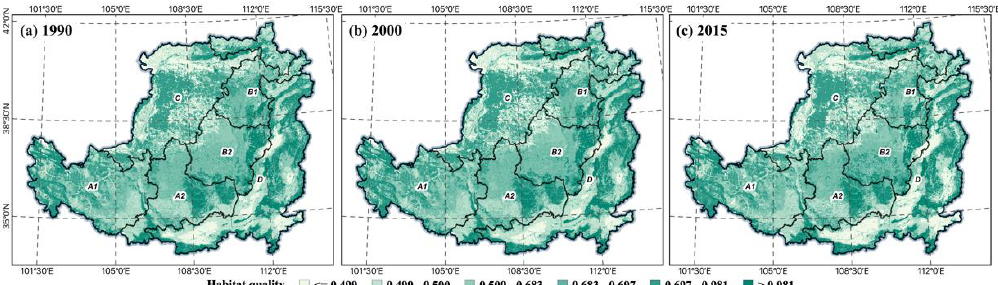
Figure 6. Habit quality change in the LP, 1990 ( a ), 2000 ( b ), 2015 ( c ).